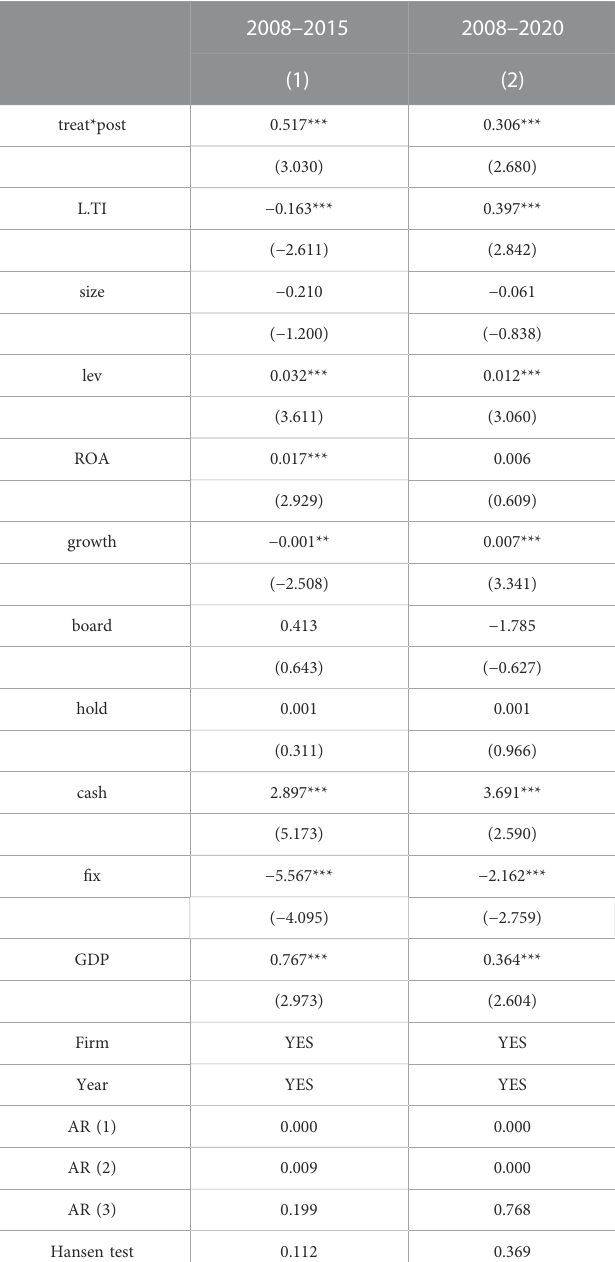
TABLE 5 System GMM estimation